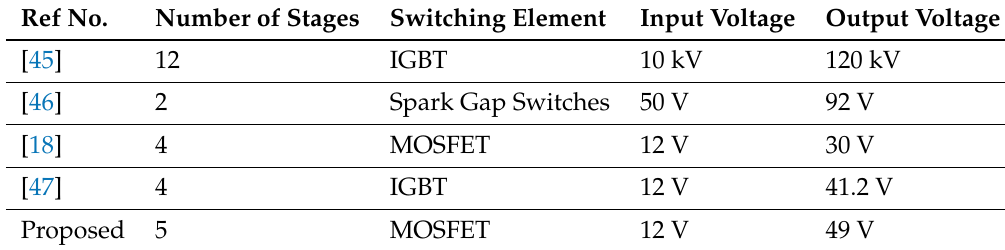
Table 2. Comparison of the previous and proposed modified Marx generator with existing circuits to generate a bipolar